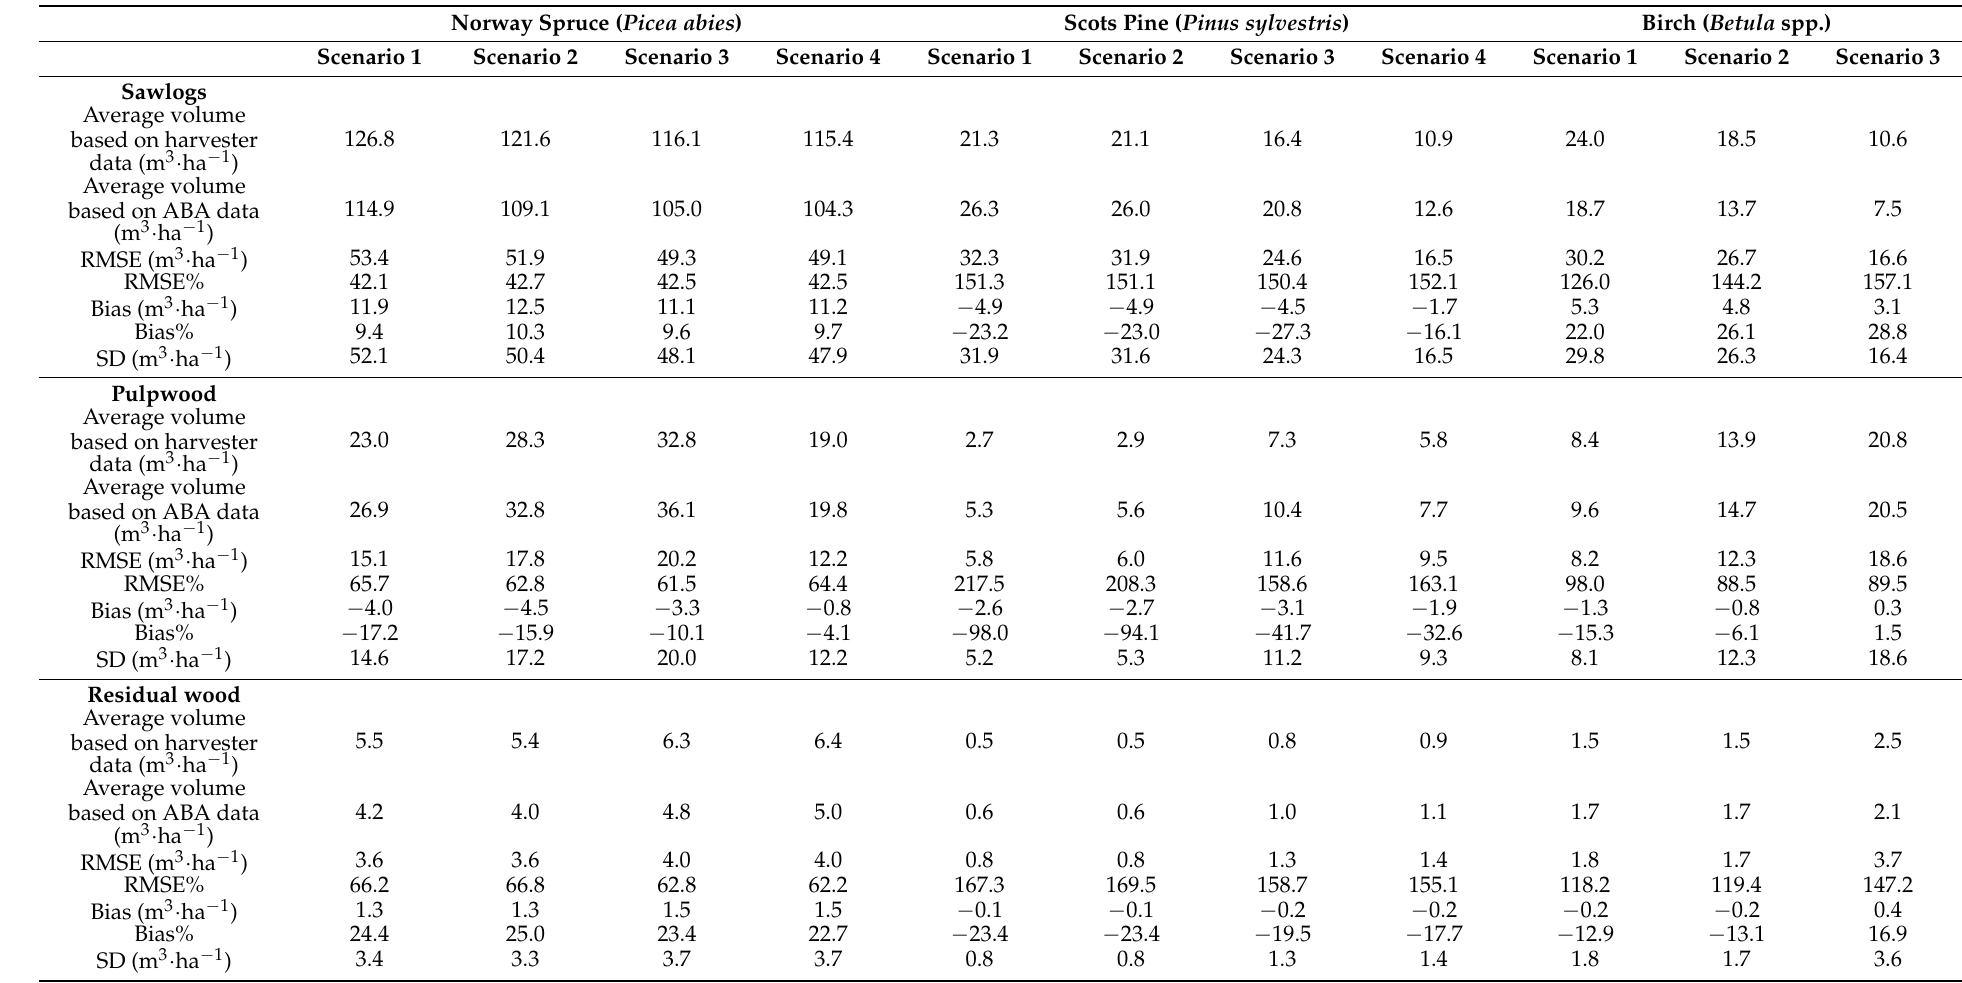
Table 4. Timber assortment volume estimates and their error statistics at the stand level ( n = 249 stands). Norway Spruce ( Picea abies ) Scots Pine ( Pinus sylvestris ) Birch ( Betula